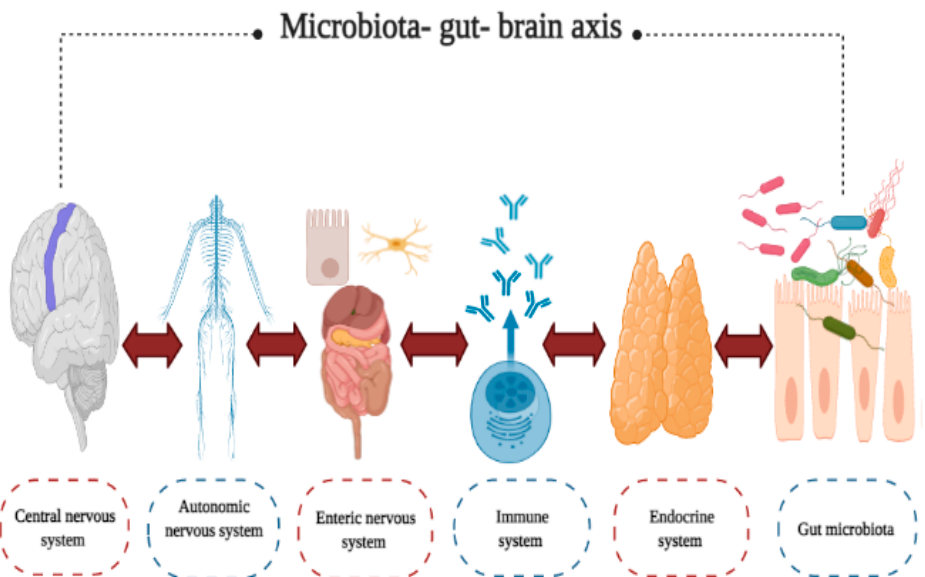
Figure 2. Microbiota–gut–brain axis, bidirectional communication network that includes the central nervous, autonomic nervous, enteric nervous, immune, and endocrine systems, and gut microbiota.